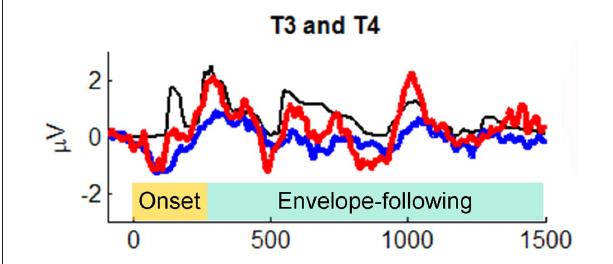
FiguRE 9 | grand average cortical responses from temporal electrodes T3 and T4 (red: right hemisphere, blue: left hemisphere) and broadband speech envelope (black) for the sentence “the young boy left home.” Ninety-five milliseconds of the prestimulus period is plotted. The speech envelope was shifted forward in time 85 ms to enable comparison to cortical responses. From Abrams et al. (2008), reproduced